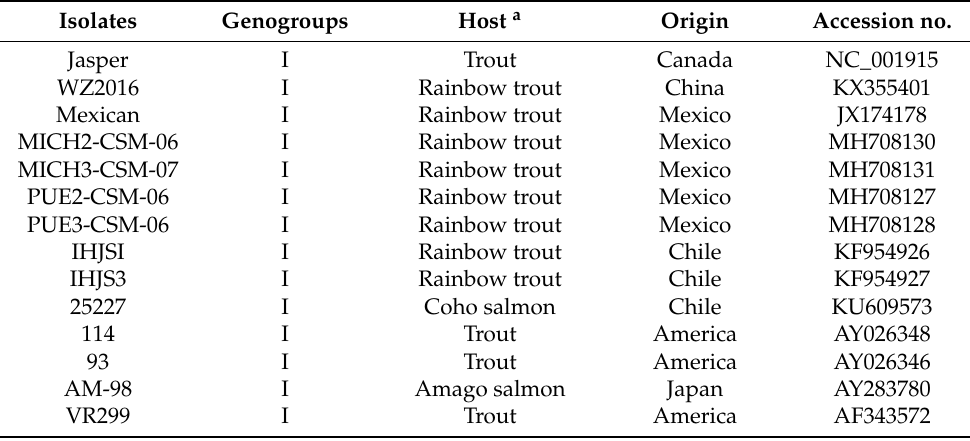
Table 2. Reference strains of aquabirnavirus used in this